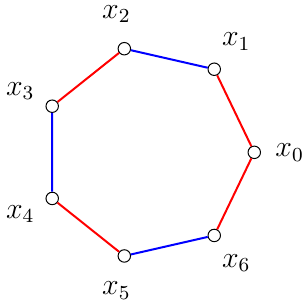
Figure 1: The 7-cycle above is 2-edge-colored such that it is properly connected. It is not flexibly connected since every path starting at x was changed to a third color, the 7-cycle would be flexibly